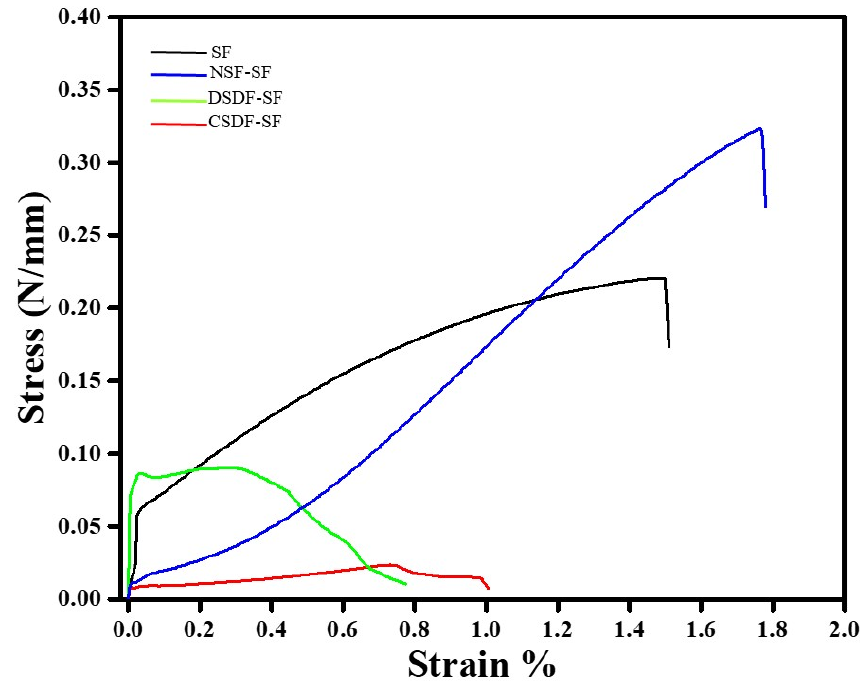
Figure 8. Stress–strain curves of uncoated and coated-SF samples.